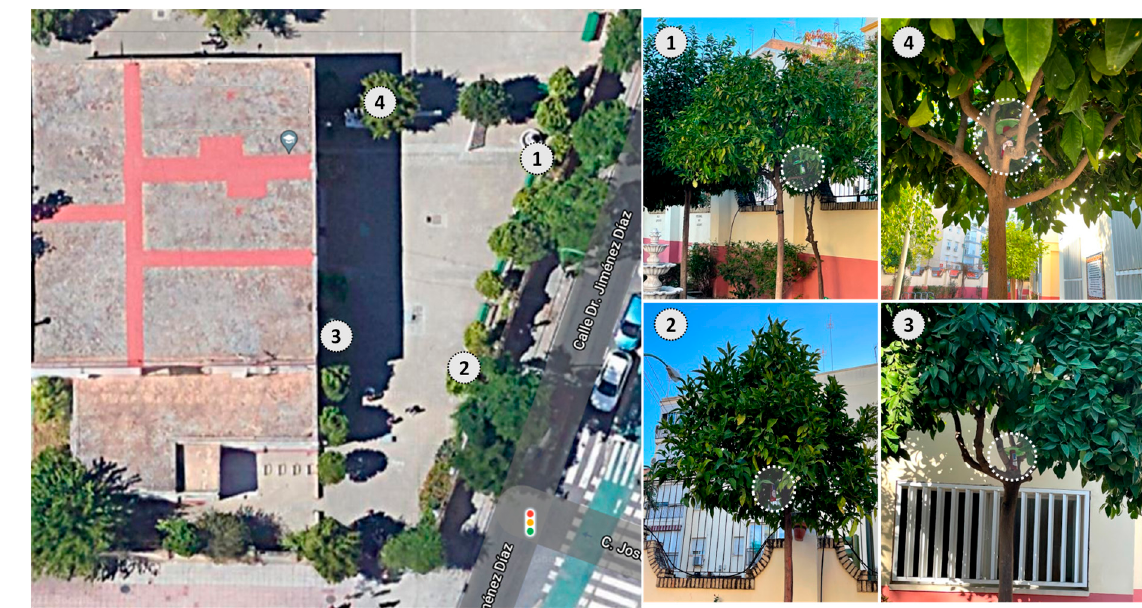
Figure 6. Disposition of the fixed sensors.